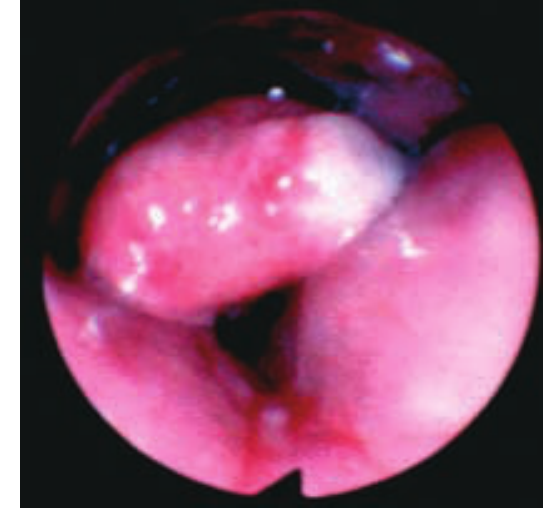
Figure 1 Inflammation and oedema of supraglottic tissue = epiglottitis.